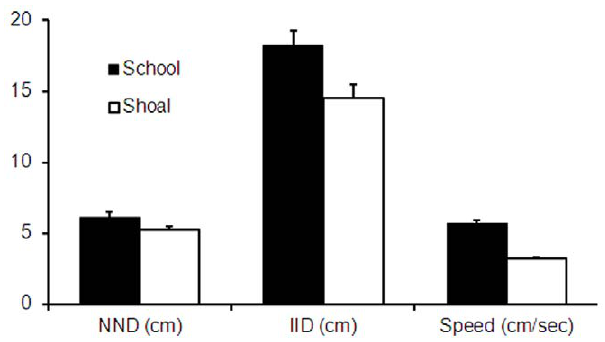
Figure 4. Differences in Nearest Neighbor Distance (NND), Inter-Individual Distance (IID), and mean speed between shoals and schools in Experiment 1 (means of 24 groups of 8 fish each). All differences were significant (paired-sample t-test, all p , 0.0001). Error bars represent 6 SEM.